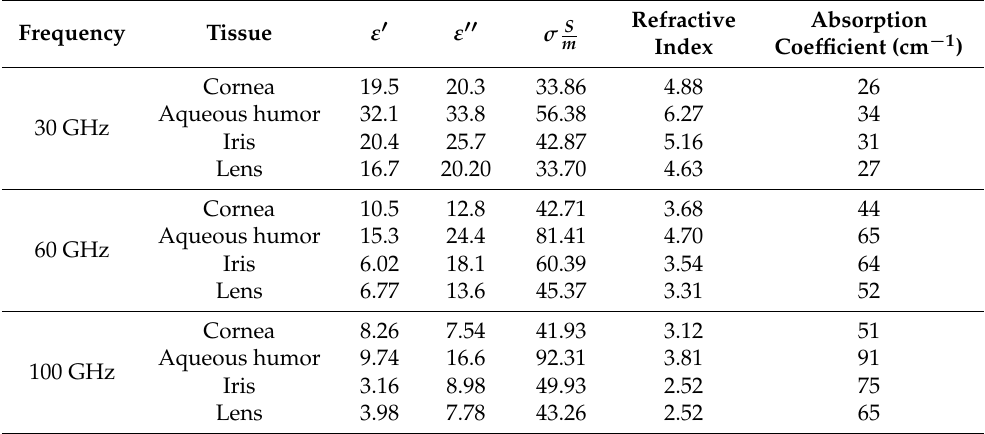
Table 1. The values used for the real ( ε (cid:48) ), imaginary ( ε (cid:48)(cid:48) ) parts of complex permittivity, and conductiv- ity ( σ ) at 35 ◦ C for the ocular tissues used in the simulation